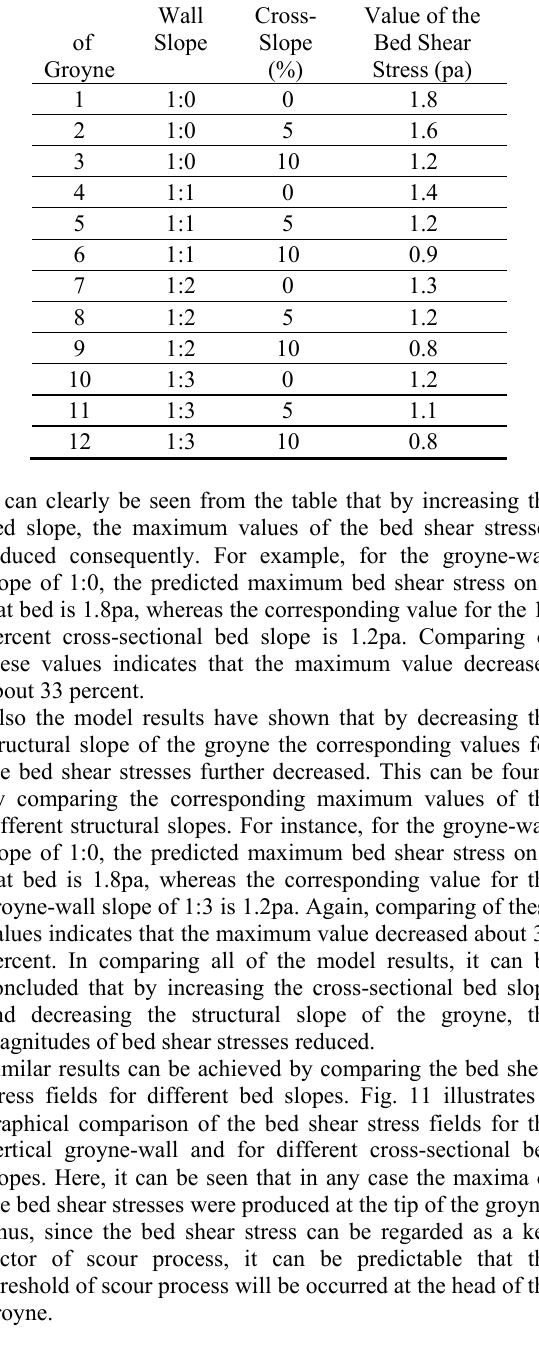
Table 2 Maximum values of bed shear stresses